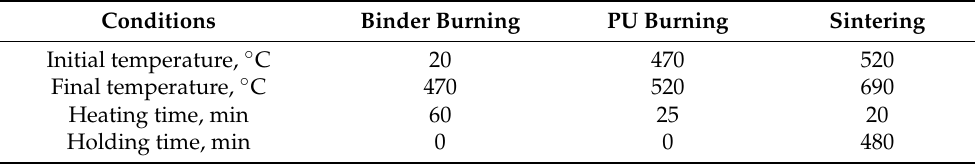
Table 1. Conditions of binder and PU burning and sintering of aluminum foam